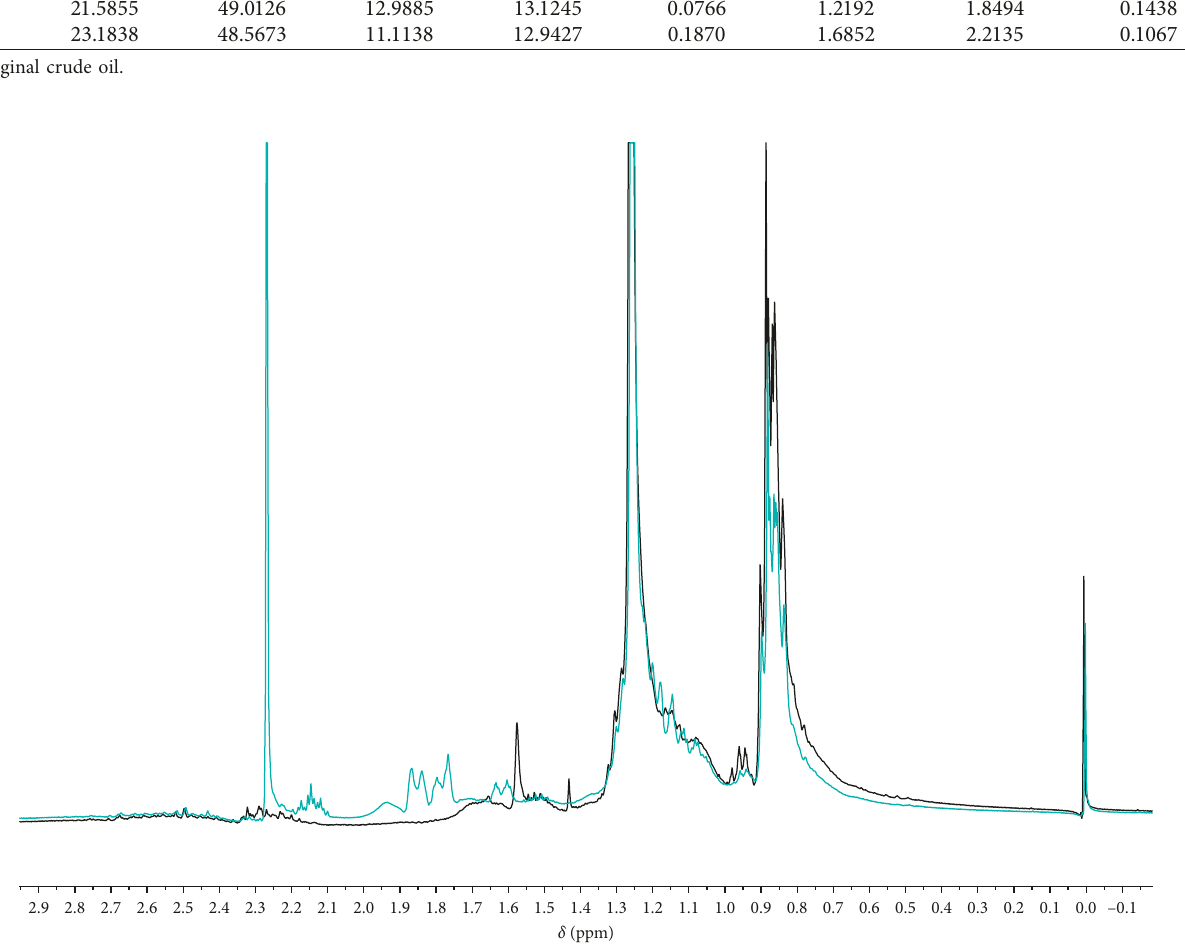
Figure 5: Expansion of NMR spectra of effluent 3 (blue) and original crude oil